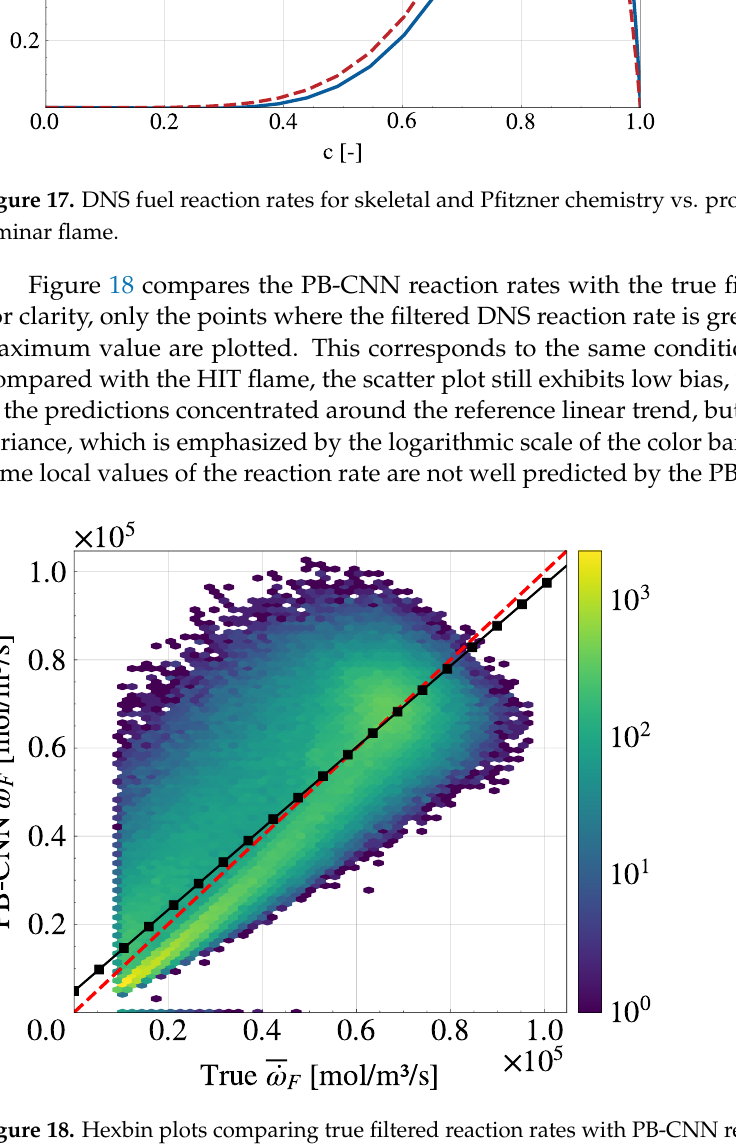
Figure 18. Hexbin plots comparing true filtered reaction rates with PB-CNN reaction rates for points in the reaction zone of the filtered DNS of R2. The black line represents the linear trend of the